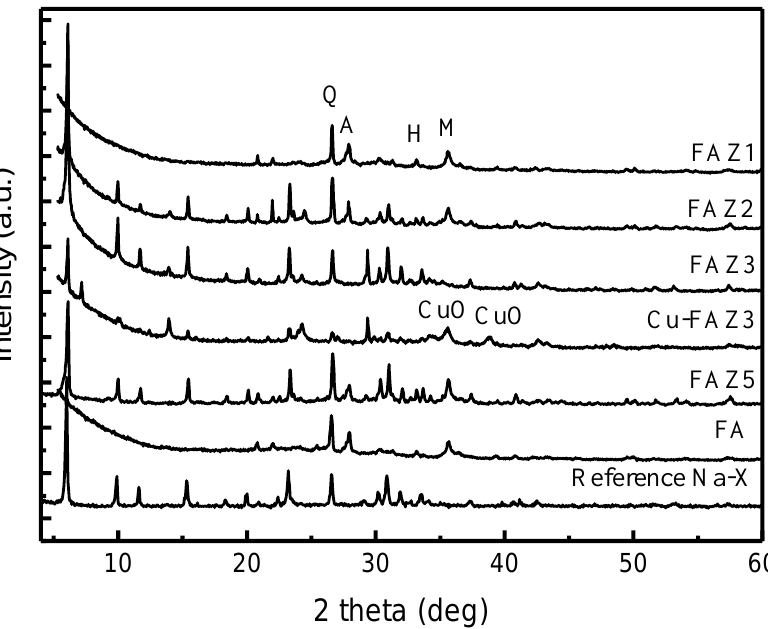
Figure2. X-raydi ff ractionpatternsofrawFA,referenceNa-X,FAZsobtainedbyhydrothermalactivation Figure 2. X-ray diffraction patterns of raw FA, reference Na-X, FAZs obtained by hydrothermal (FAZ1, FAZ2), double-stage fusion–hydrothermal synthesis (FAZ3) and atmospheric crystallization activation (FAZ1, FAZ2), double-stage fusion – hydrothermal synthesis (FAZ3) and atmospheric (FAZ5), and CuO-modified FAZ4 (Cu–FAZ4) (quartz (Q), anorthite (A), hematite (H), magnetite crystallization (FAZ5), and CuO-modified FAZ4 (Cu – FAZ4) (quartz (Q), anorthite (A), hematite (H), magnetite (M)).